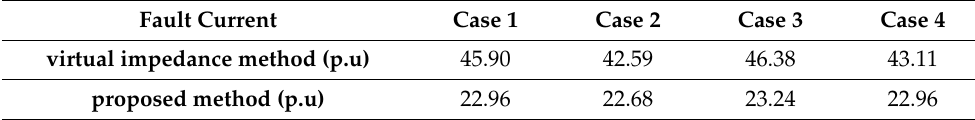
Table 5. The estimated short circuit current value at bus No. 8uses two techniques. Fault Current virtual impedance method